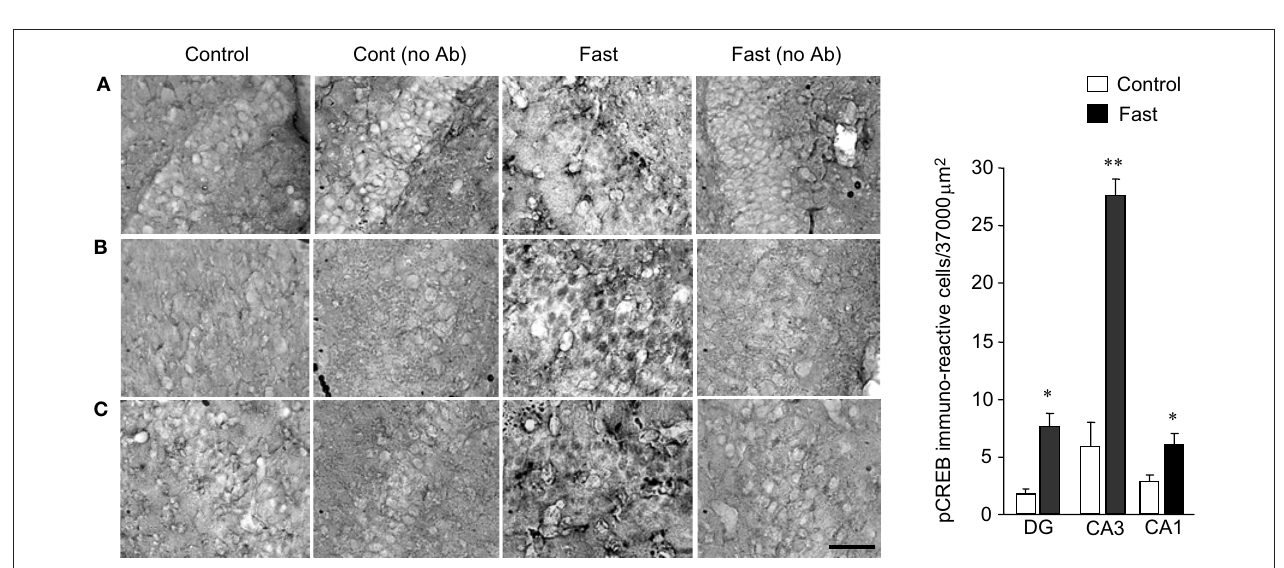
FIGURE 2 | pCREB immunoreactivity in the hippocampus. (A) Dentate gyrus. (B) CA3. (C) CA1. Photomicrographs in (A) to (C) were obtained from control, control without a primary antibody, fast, and fast without a primary antibody (from left to right). The graph on the right end shows a group data for control vs. fast with a mean ± SEM. Calibration: 50 μ m (applies to all photomicrographs). ** p < 0.001, * p <